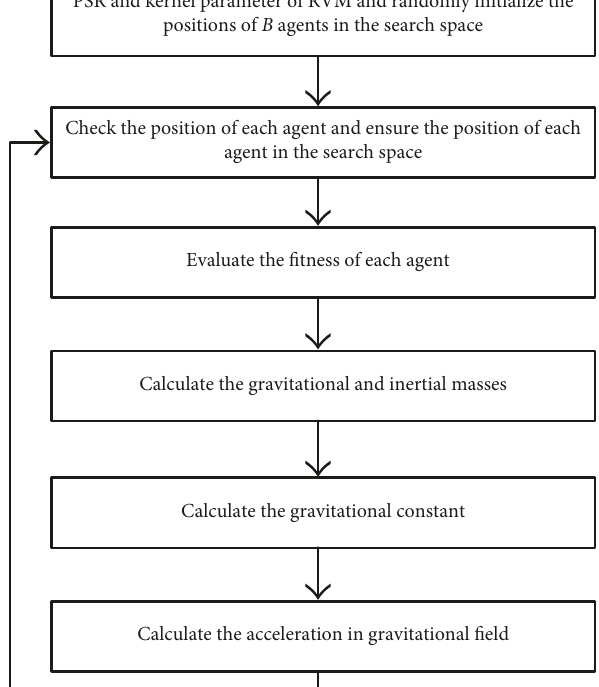
Table 1: Encoding m (embedding space dimension) and τ (time delay) of PSR and p (kernel parameter) of RVM.